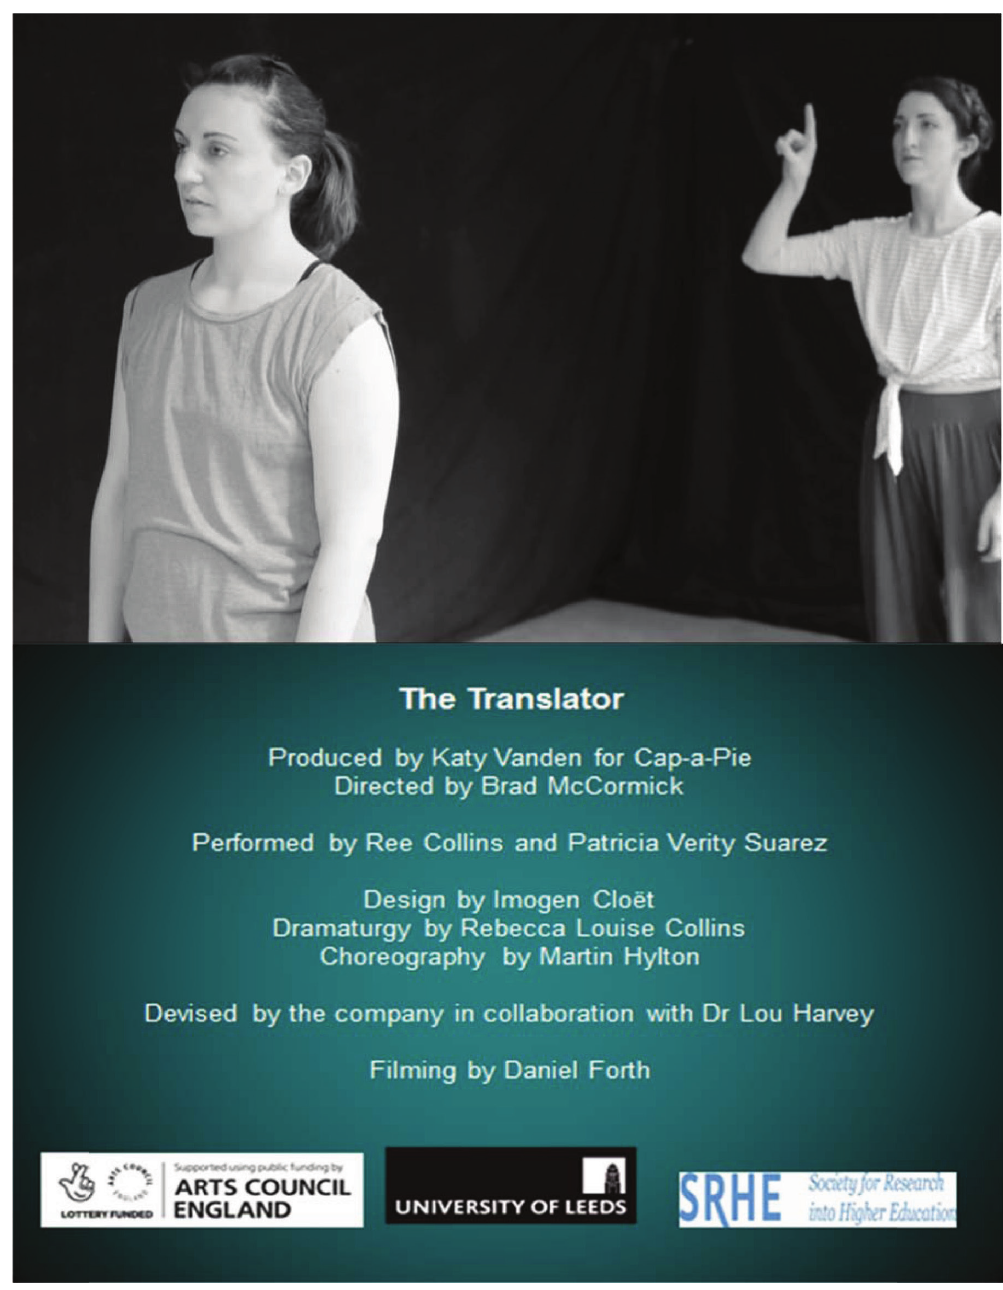
Figure 1: Still and title card from The Translator , a video of rehearsal scenes